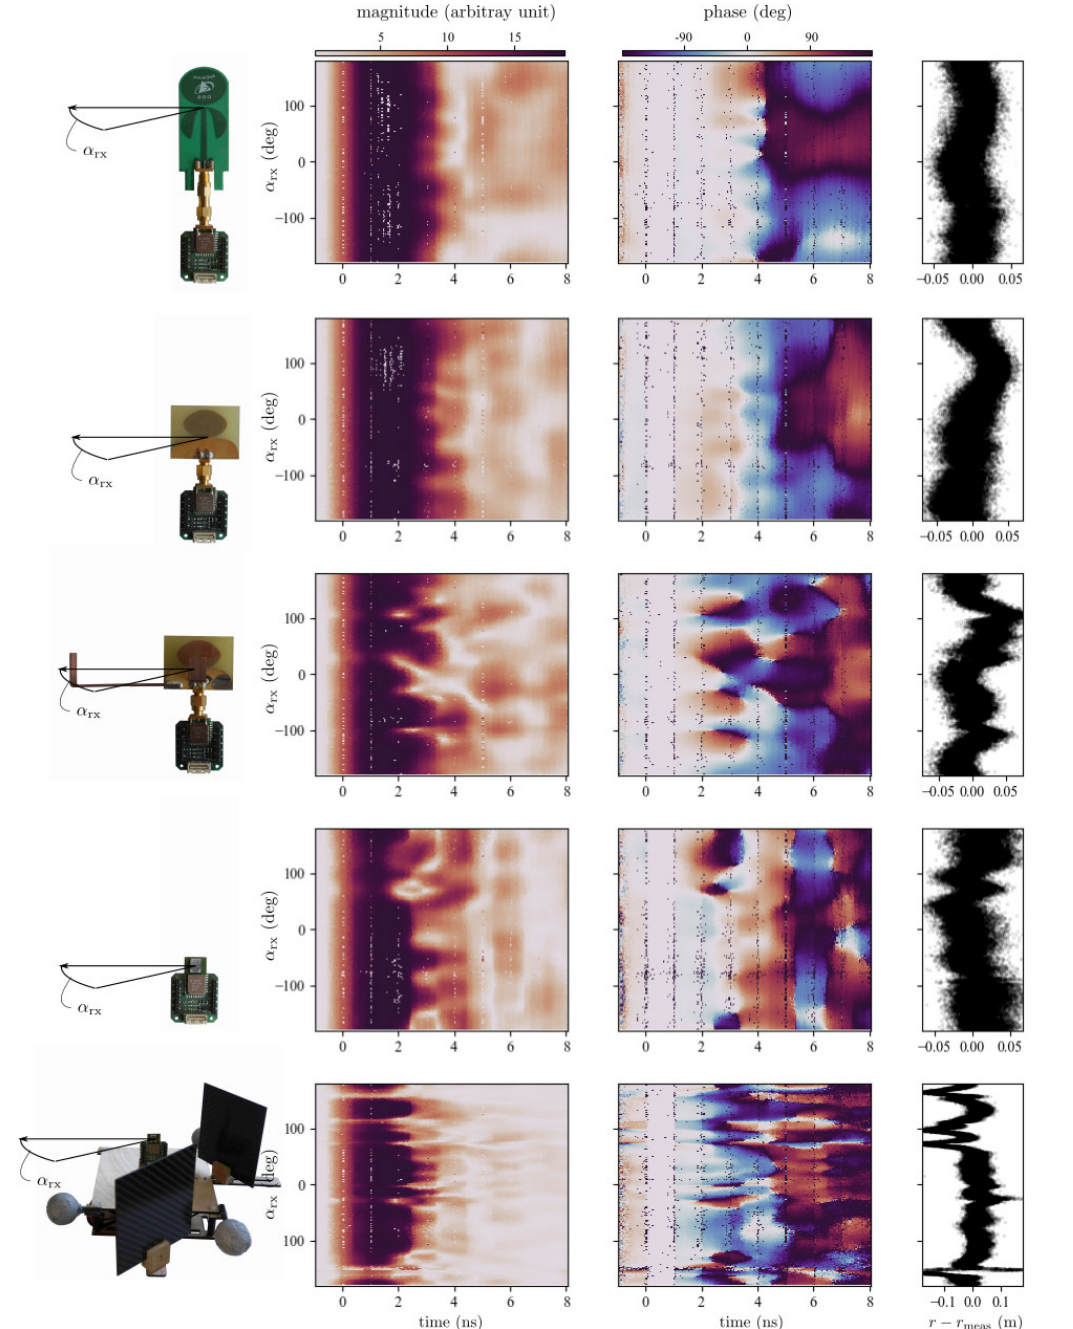
Figure A1. The complex CIR envelope for different receiver antenna configurations is shown for different AOA with the estimated first path location at t = 0ns. The transmission antenna is always a Broadspec Time Domain